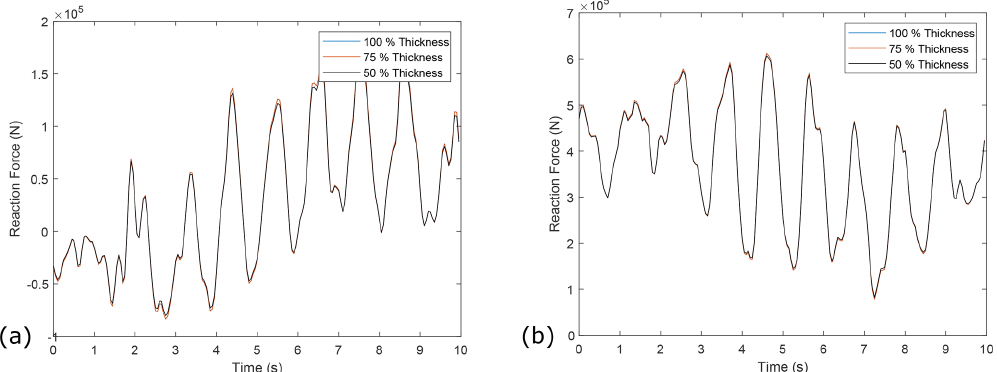
Figure B1. (a) Example time series of reaction force results in the horizontal plane from the analytical DTRB (with torsional springs) model when the shaft thickness is altered. (b) Example time series of reaction force results in the vertical plane from the analytical DTRB (with torsional springs) model when the shaft thickness is altered.